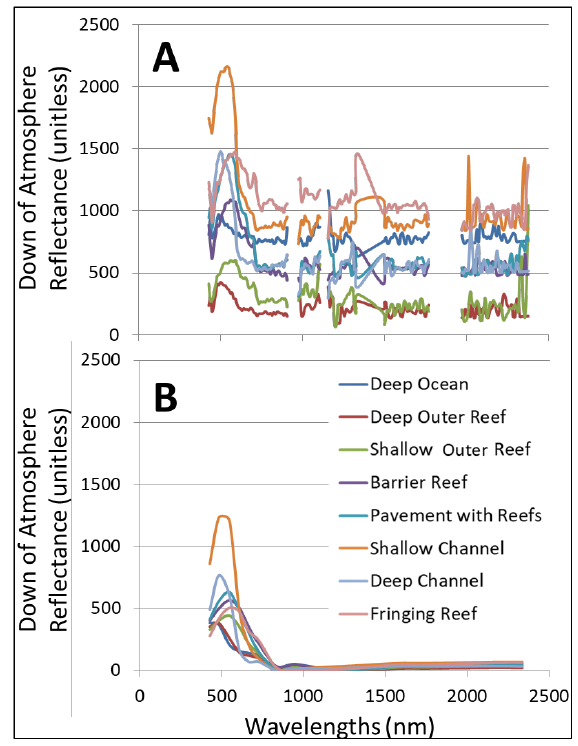
Figure 3. Hyperion spectral signatures of the 10 classes (A: 8 marine, B: 2 terrestrial). 167 bands out of 220 were operable